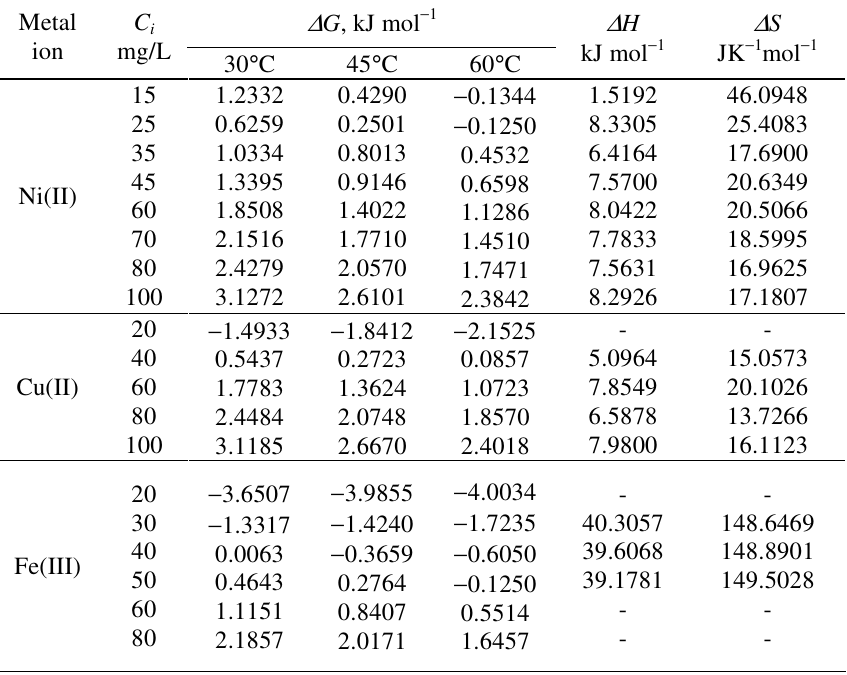
Table 4. Thermodynamic parameters for the adsorption of metal ions on CC